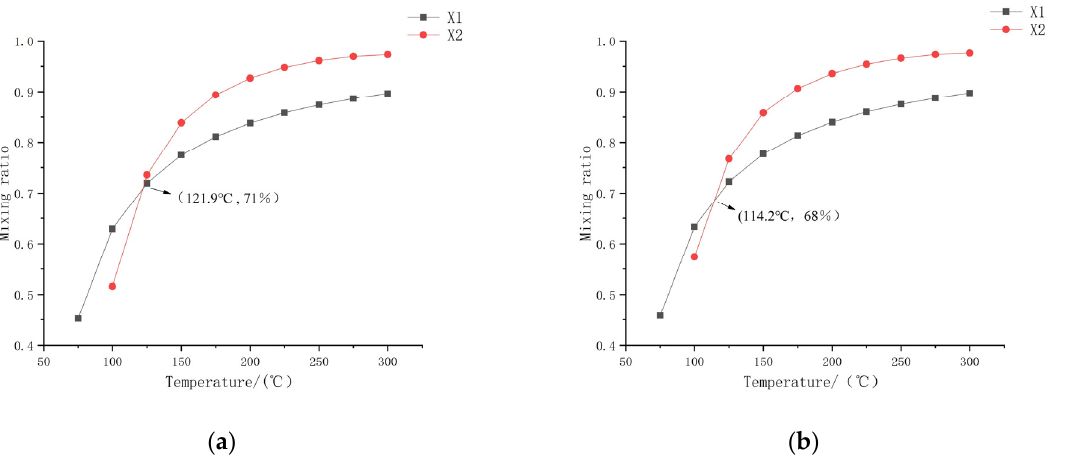
Figure 6. Graphical representation of the ratio of mixed cold water and deep hot water in the study area: ( a ) DXR-8; ( b ) DXR-9.